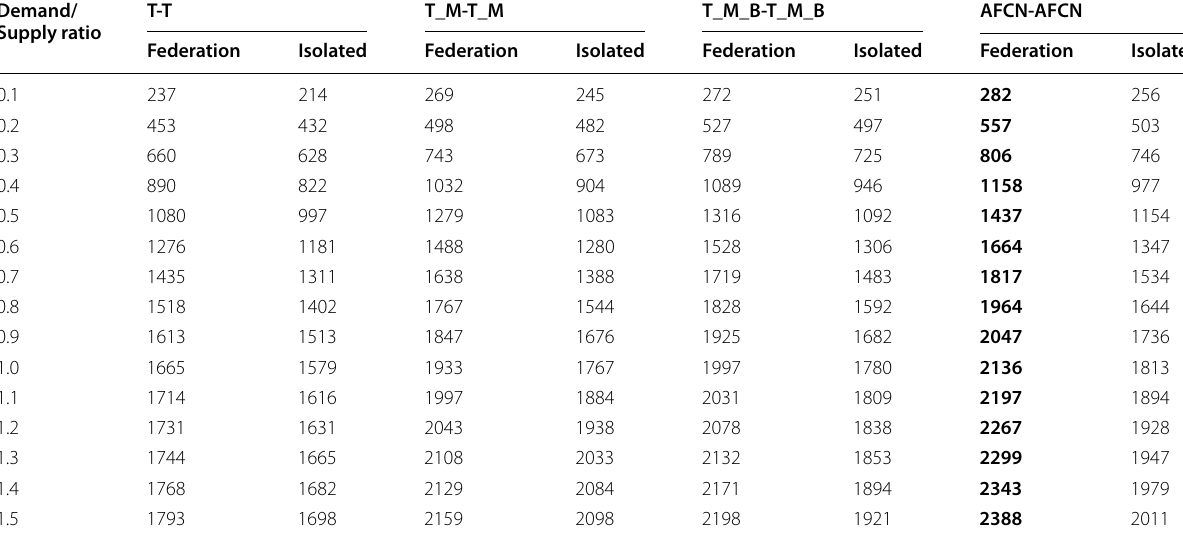
Table 4 Avg. revenue of federation and isolated PAs for different negotiation models Demand/ Supply